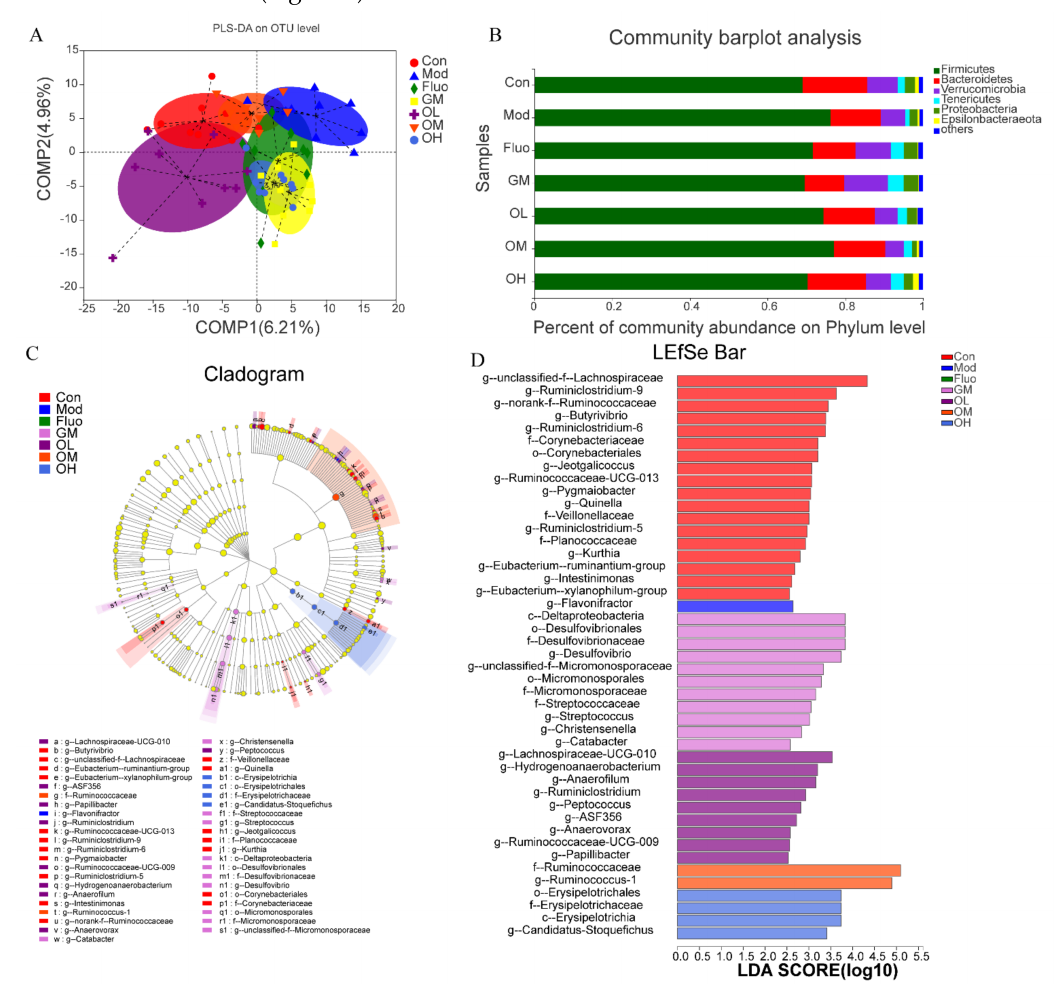
Figure 6. Jasmine tea modulated gut microbiota compositions of depressive-like rats. ( A ). PLS- DA analysis of gut microbiota based on OTU relative abundance among the control group and CUMS-induced depression or jasmine tea administration. ( B ). Taxonomic profiling of bacteria at the phylum level of gut microbiota in different treatments. ( C ). Cladogram analysis among different groups. The central point represents the root of the tree (bacteria), and each ring represents the next lower taxonomic level (phylum through OTUs). The diameter of each circle represents the relative abundance of the taxon. When full identification was not possible, g_ or s_ alone was used for the genus or species, respectively. ( D ). Column chart of linear discriminant analysis (LDA). PLS-DA, Partial least squares discrimination